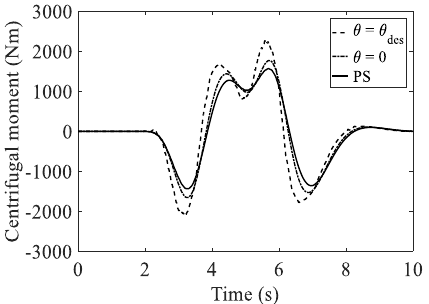
Figure 15. Time-domain response of the vehicle centrifugal moment.